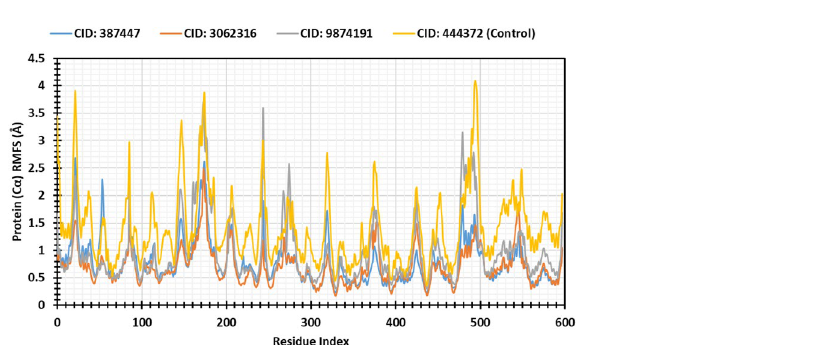
Figure 6. Graphs represent the MD simulation for the selected protein-ligands complex during 500 ns simulation time. Herein, representing the compounds ( A ) CID_387447, ( B ) CID_3062316, ( C ) CID_9874191, and ( D ) CID_444372 RMSD values of MCM7 protein (blue curves) and ligands (red curves).